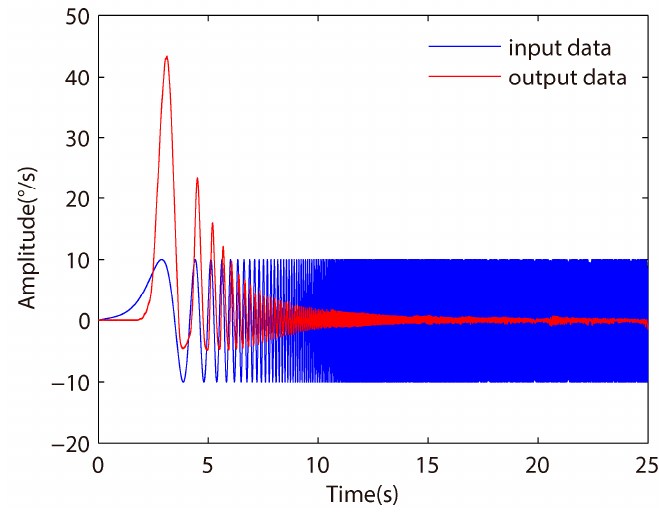
Figure 2. Input and response signal curve of pitch axis open-loop test.